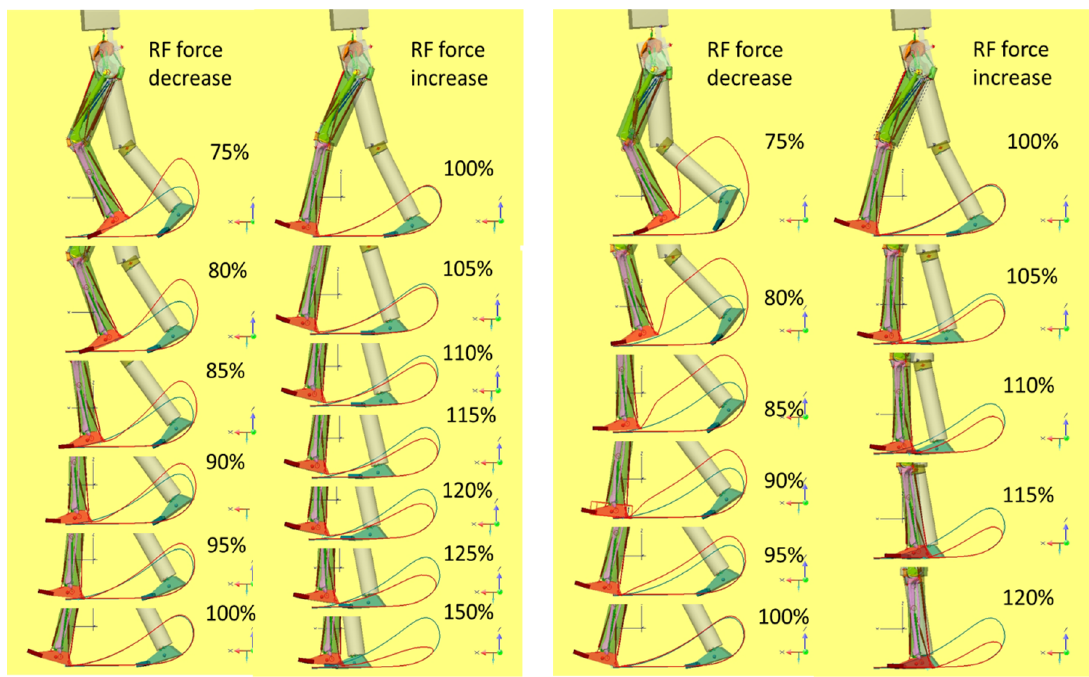
Figure 7. Foot position achieved at foot-floor contact when RF force was changed (the numbers show the percentage of RF force). The two columns on the left refer to a condition in which only the knee joint was controlled by the RF force, while the hip joint kinematics was imposed (this corresponded to full compensation by hip muscles); the two columns on the right refer to a condition in which both hip and knee were dependent on RF force.